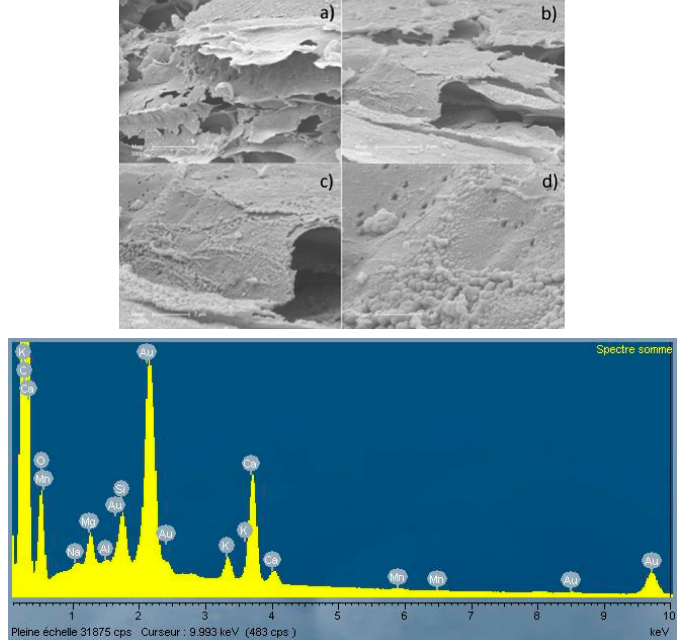
Figure 6. SEM photographs and X-ray fluorescence analysis of the surface of the biochar produced after pyrolysis of wood particles at 1400 °C and different enlargements ( a ) ×5000; ( b ) ×10,000; ( c ) ×20,000; and ( d ) ×50,000.